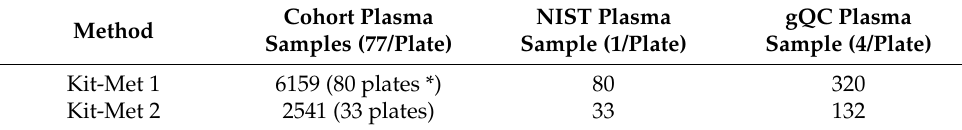
Table 2. Summary of